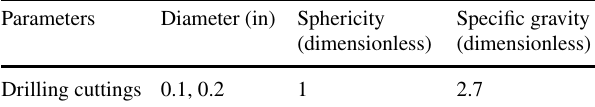
Table 3 Cutting